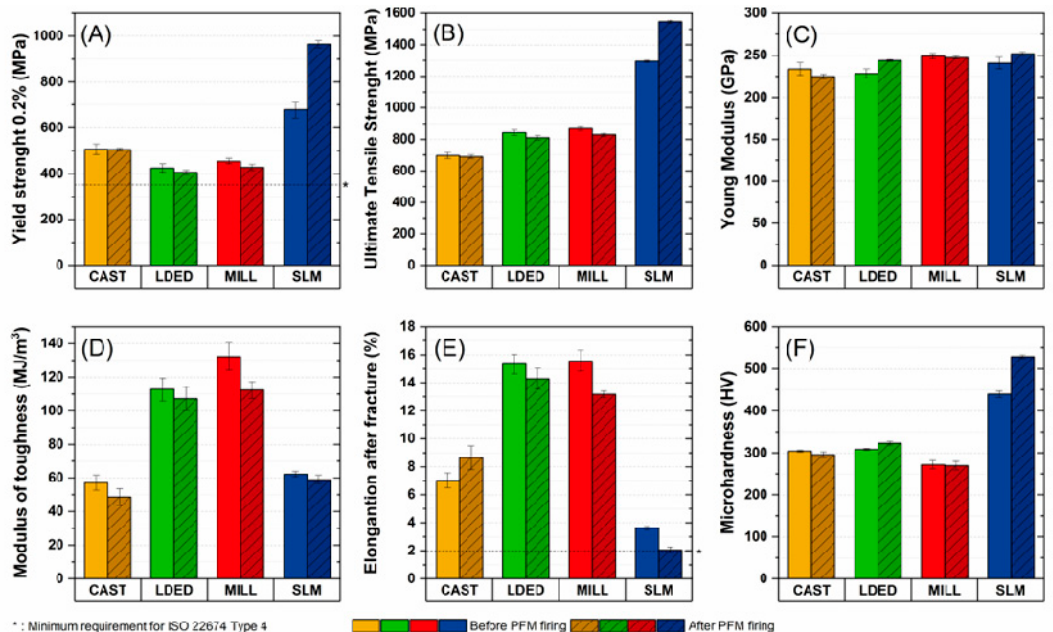
Figure 7. Mechanical properties of the different techniques evaluated before and after PFM firing simulation: yield strength ( A ), ultimate tensile strength ( B ), Young modulus ( C ), modulus of toughness ( D ), elongation after fracture ( E ), and microhardness ( F ). Error bars indicate the standard error of the mean.